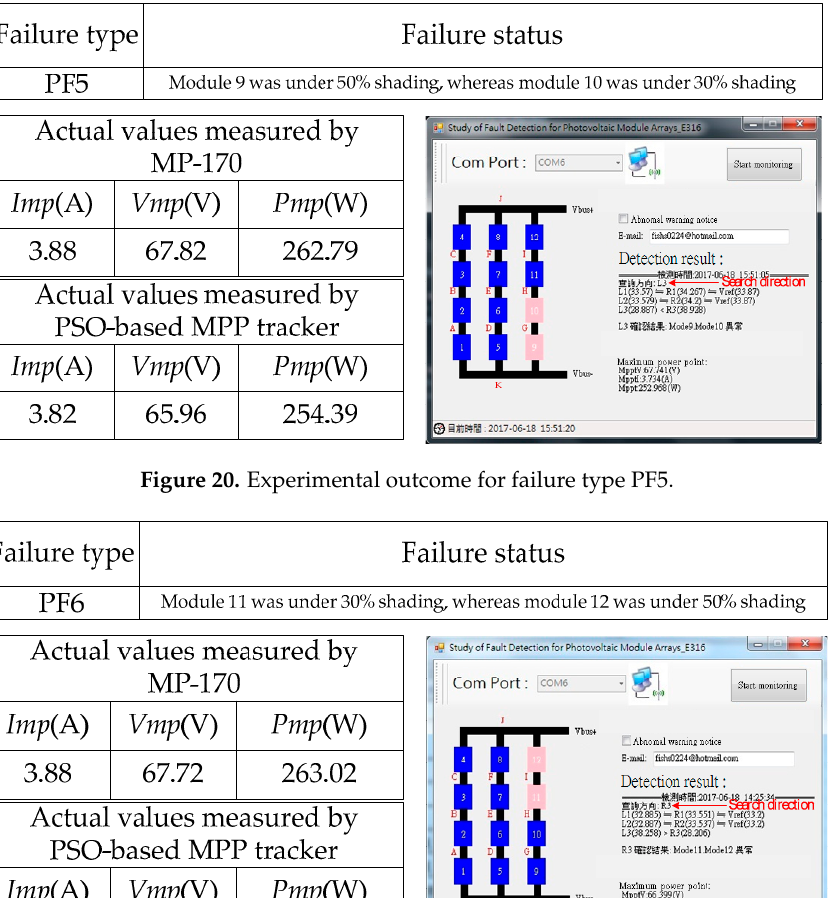
Figure 19. Experimental outcome for failure type PF4.